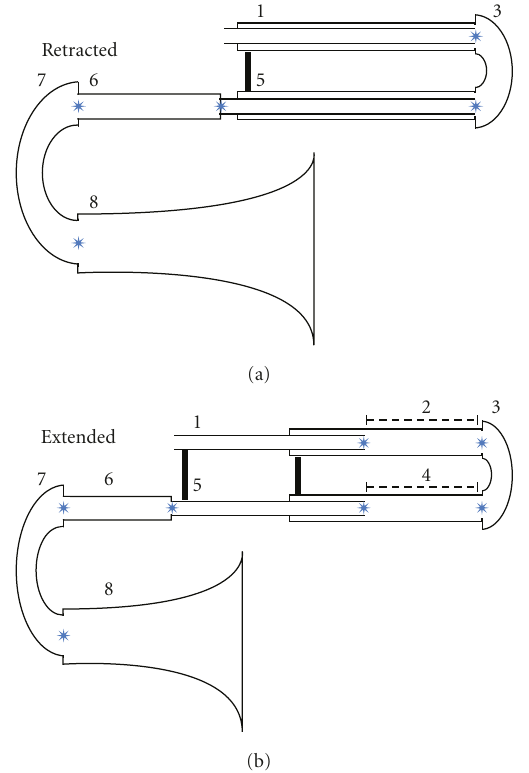
Figure 17: Interior view of trombone, in both fully retracted and fully extended positions, showing assembly of components from